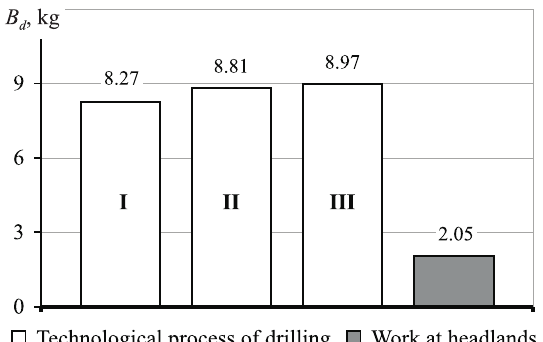
Fig. 7. Distribution of fuel consumption during the process of drilling test (3867 s) by the operating